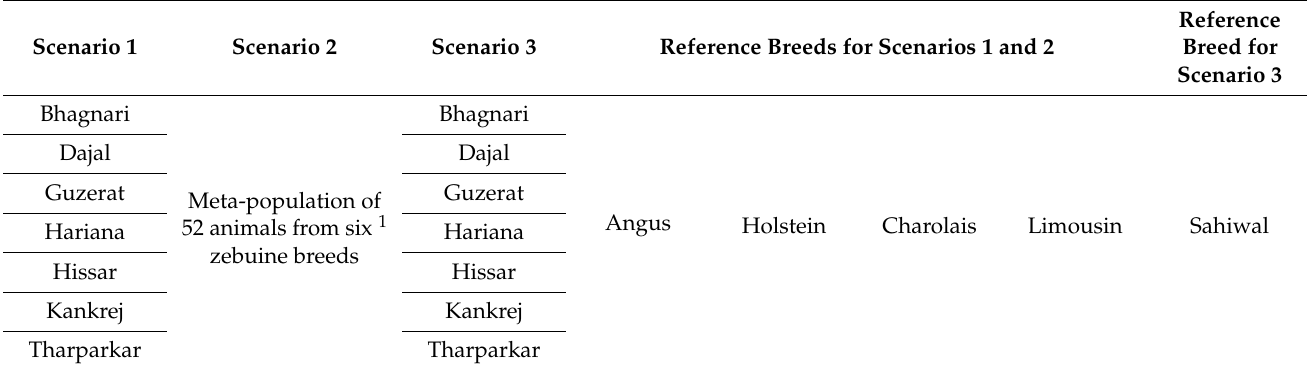
Table 2. Outline of the experimental design for each